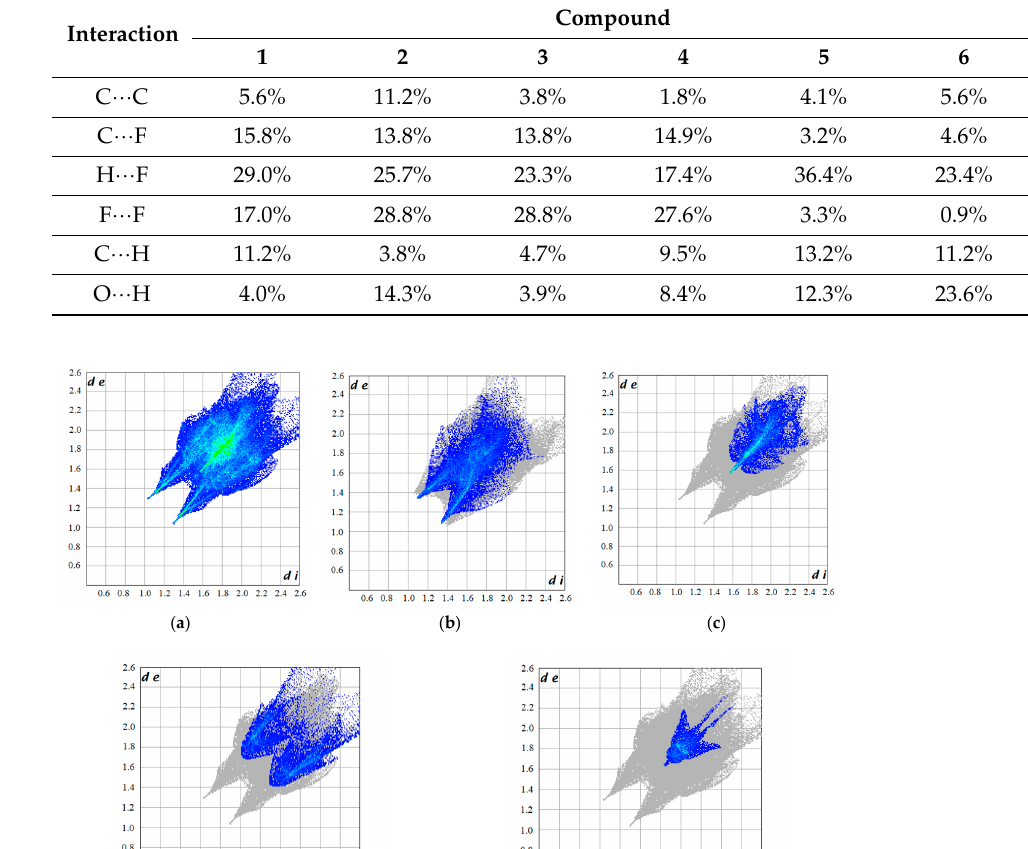
Table 2. Contribution of non-covalent interactions to the total Hirshfeld surface of complexes 1–6 .